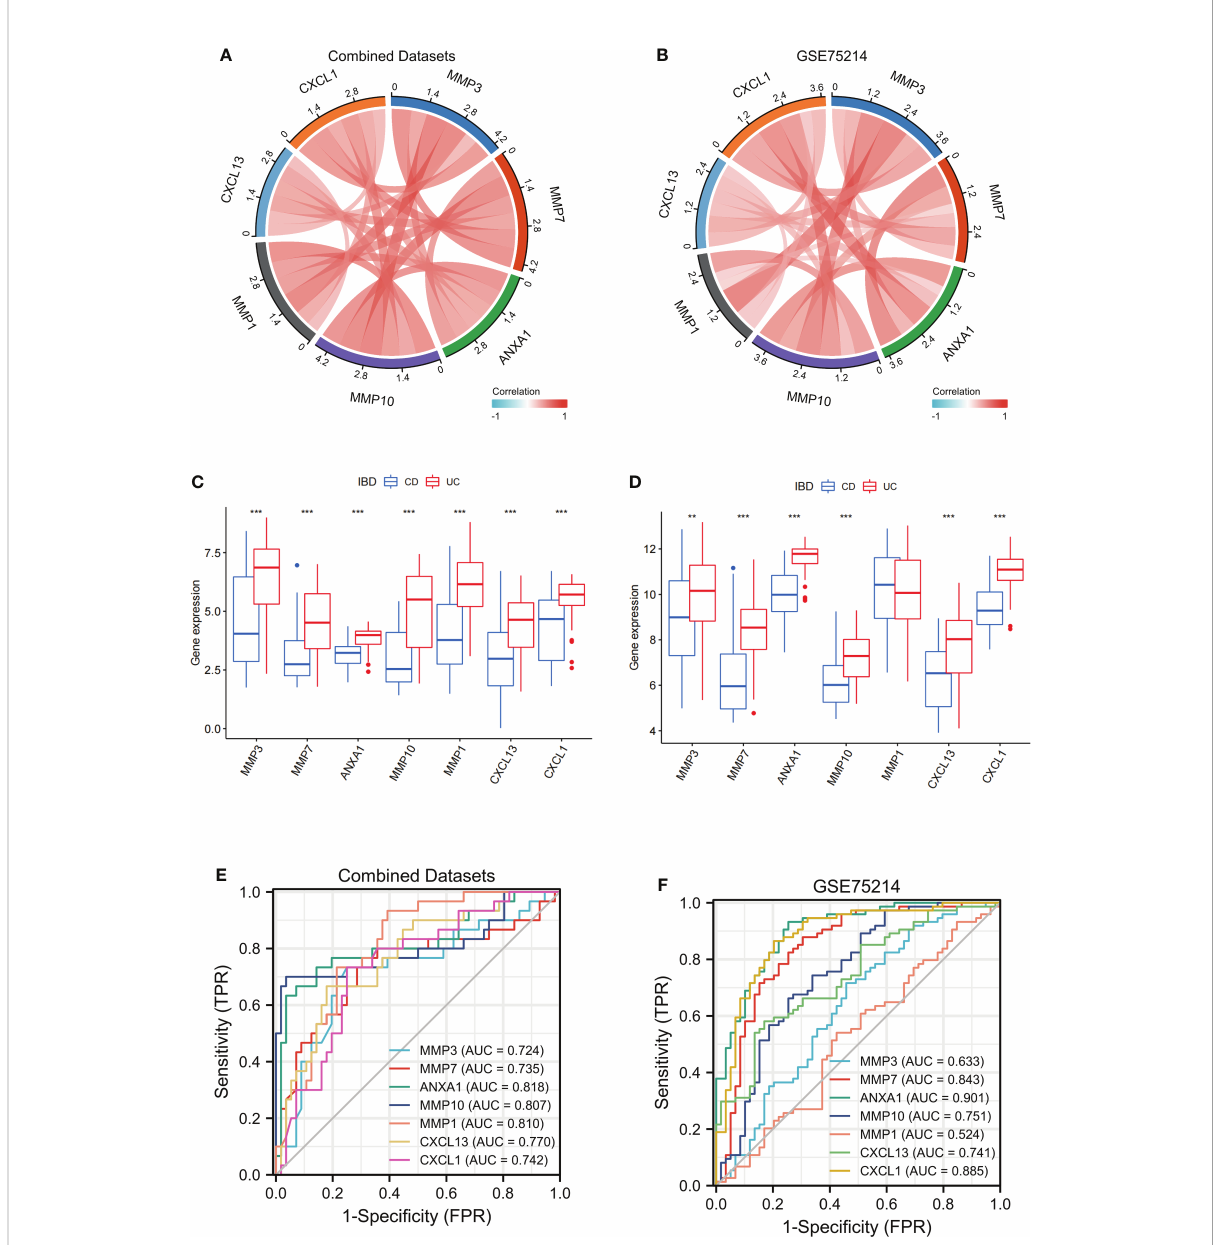
FIGURE 8 Veri fi cation of MMP-associated genes in different IBD cohorts The correlation between the levels of internal MMP-associated genes in both Combined Datasets (A) and the GSE75214 dataset (B) using a Spearman correlation analysis. The differences in MMP-associated genes between CD and UC were examined in both the Combined Datasets (C) and the GSE75214 dataset (D) using the limma package. ROC curves estimating the diagnostic performance of the MMP-associated genes ANXA1, MMP10, MMP1, CXCL13 and CXCL1 in the discrimination of IBD patients in the Combined Datasets (E) and GSE75214 (F) . ** indicates P<0.01, *** indicates